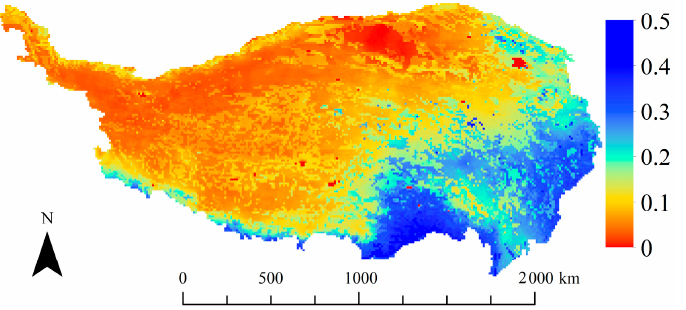
Figure 8. Mean daily SMC from the NASA’s Soil Moisture Active Passive (SMAP) instrument during June–September in 2015 as a reference. June–September in 2015 as a